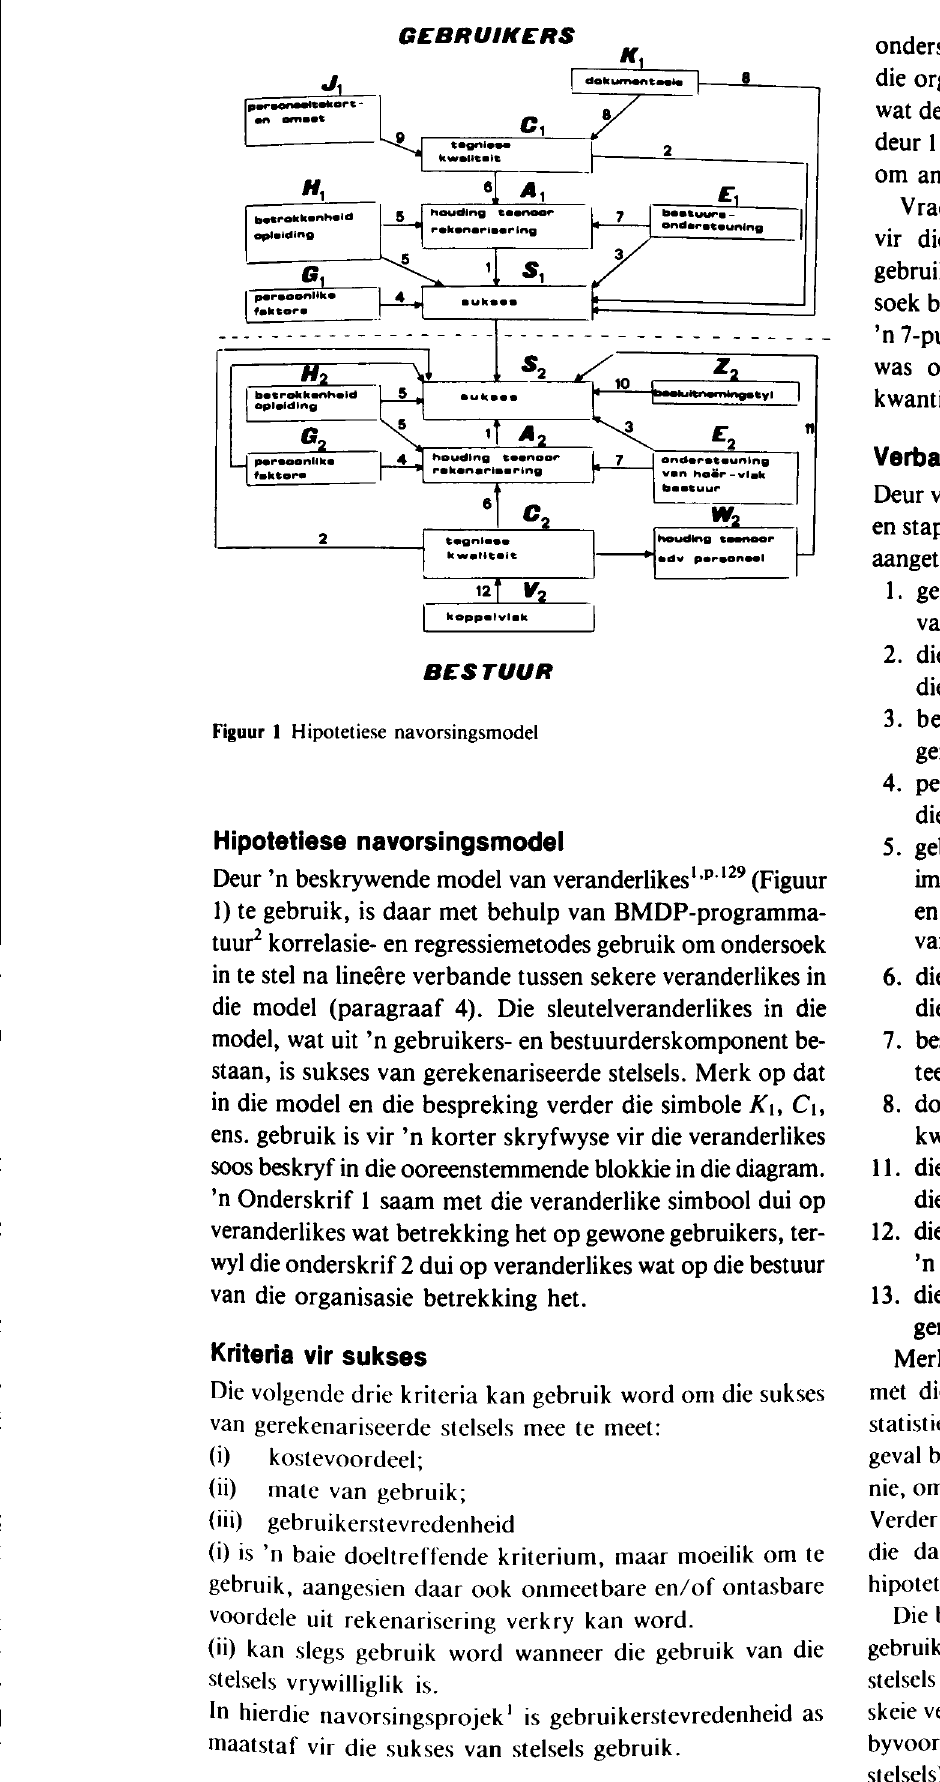
Figuur I Hipotetiese navorsingsmodel